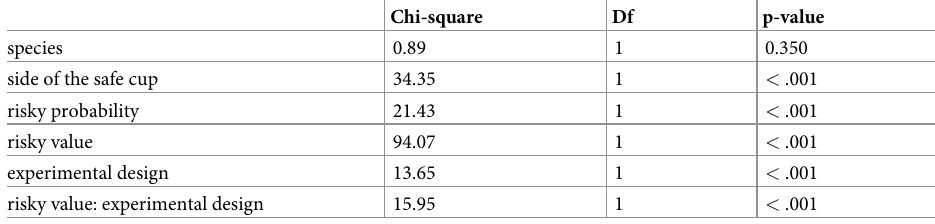
Table 6. Fixed effects of the final model. The table reports the results of the analysis of deviance (type II Wald chi- square tests) for Experiment 1 and 2 combined. Only trials with P < 1 were considered.